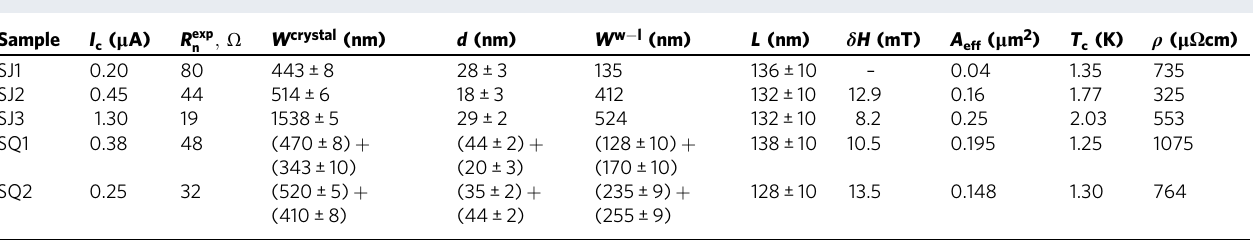
Table 1 Relevant parameters for all the measured devices at 700 mK.